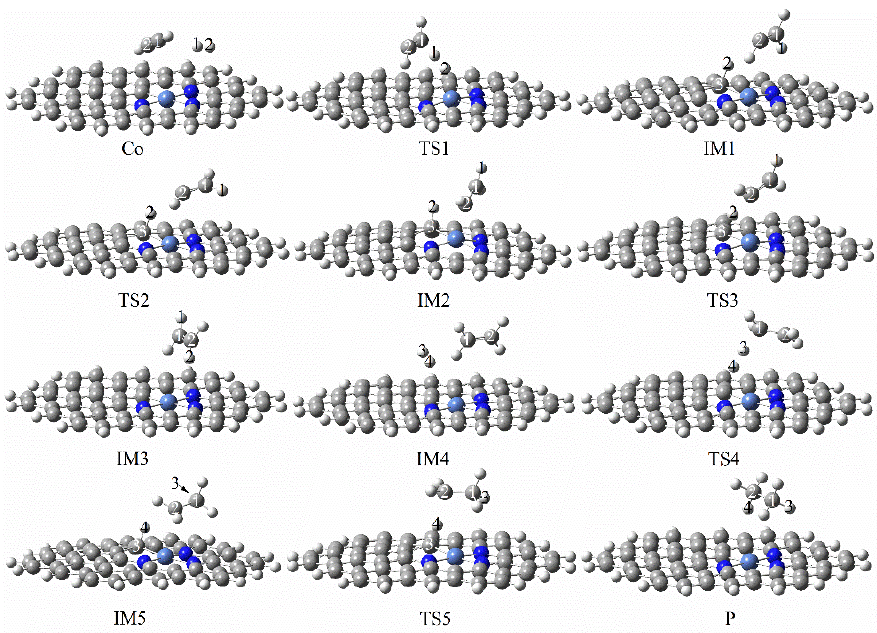
Figure 13. Optimal reaction pathway for acetylene hydrogenation catalyzed by graphene-NiN 3 cat- alyst.